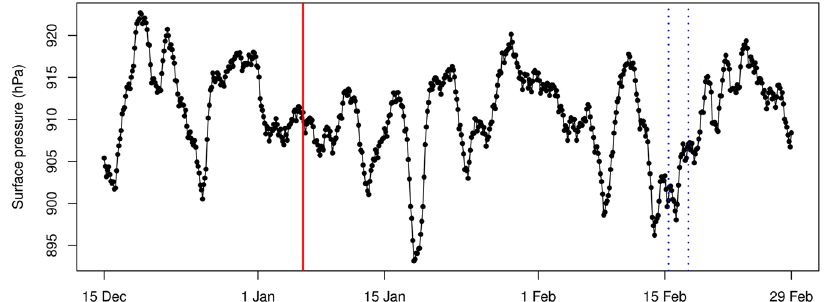
Figure 5. Surface pressure at the Punggye-ri nuclear test site obtained from ECMWF analyses. The full red vertical line shows the timing of the DPRK underground explosion, the dotted blue vertical lines show the possible release period for the Punggye-ri nuclear test